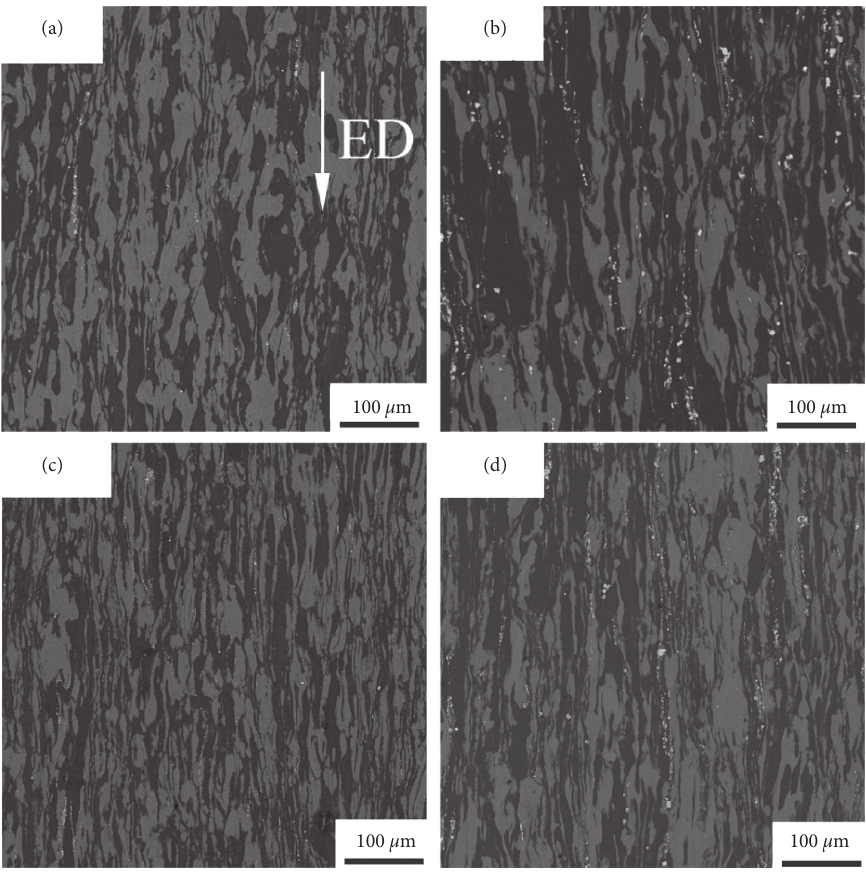
Figure 4: BSE images of extruded (a) MYZ, (b) MYZC, (c) MYZN, and (d) MYZCN alloys. Table 3: Volume fraction of each phase in the four